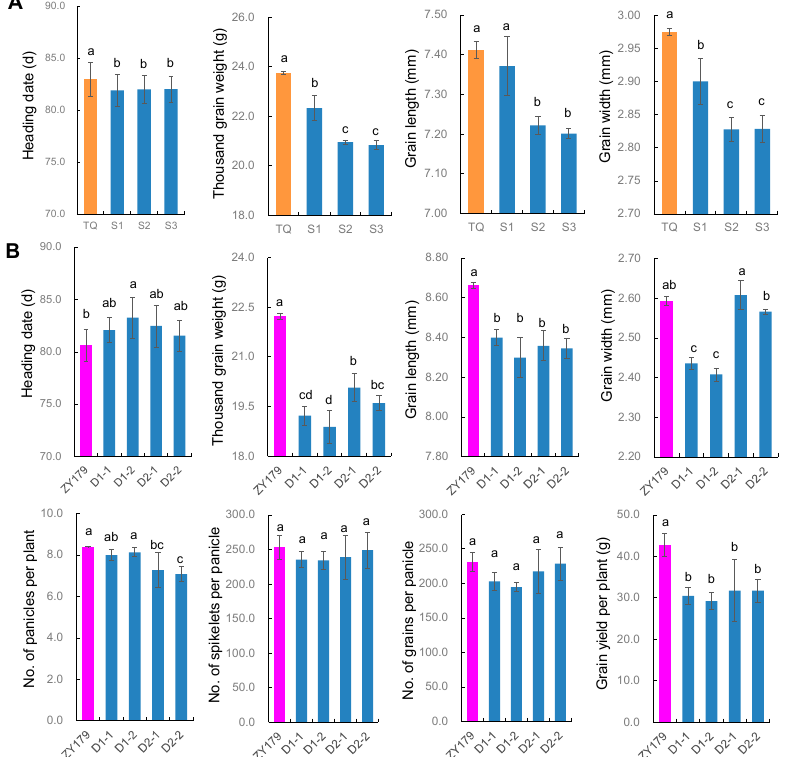
Figure 2. Phenotypic differences among each recipient and its mutants. ( A ) Heading date and grain size traits in Teqing and its mutants. ( B ) Heading date, grain size and yield traits in ZY179 and its mutants. Values are given as the mean ± SD ( n = 3). Values with different letters are significantly different at p < 0.05 based on Duncan’s multiple range